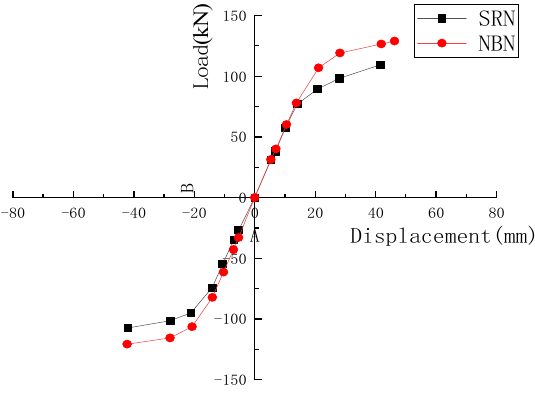
Figure 7. The skeleton curves .